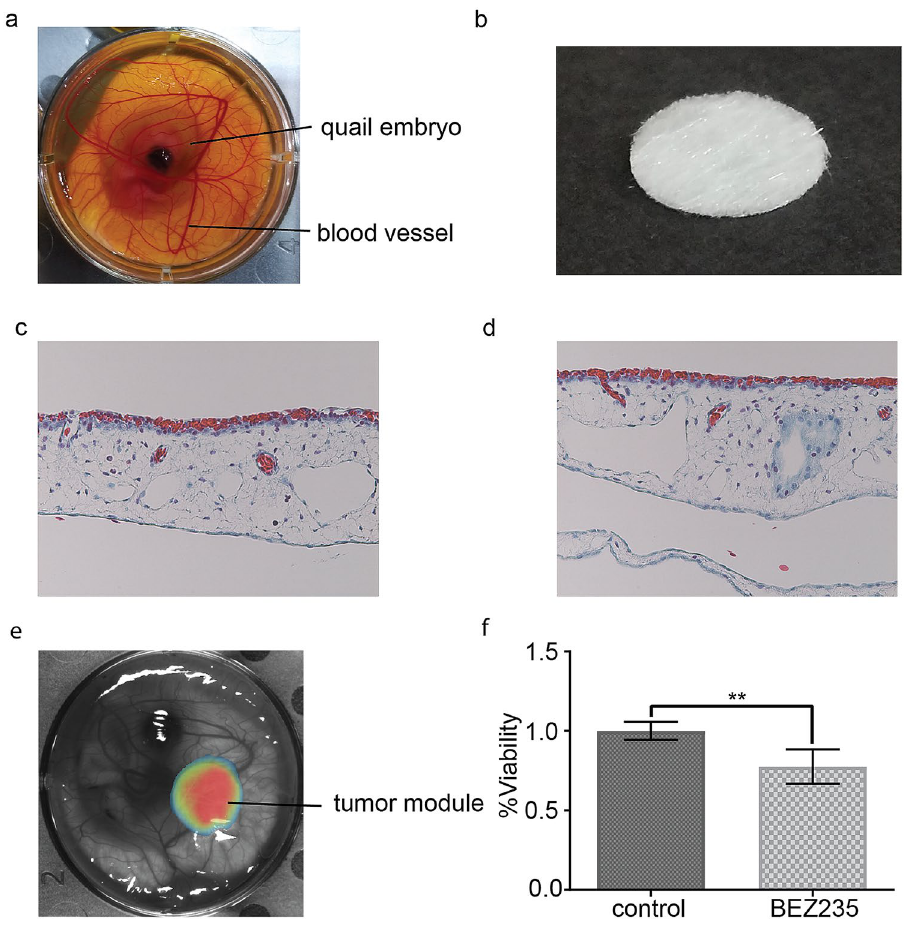
Figure 3. Quail xenograft assay. ( a ) a quail embryo at e7. ( b ) An unused 3D scaffold 9.5 mm in diameter for use as a tumor module. ( c , d ) Cross sections of the CAM. ( e ) representative pseudo-colorized image of viable, luciferase-expressing tumor cells 72 h after xenografting on the CAM. ( f ) The assay used murine rhabdomyosarcoma cells treated with BEZ235 (n = 6) or vehicle control (n = 4). **, significance p =